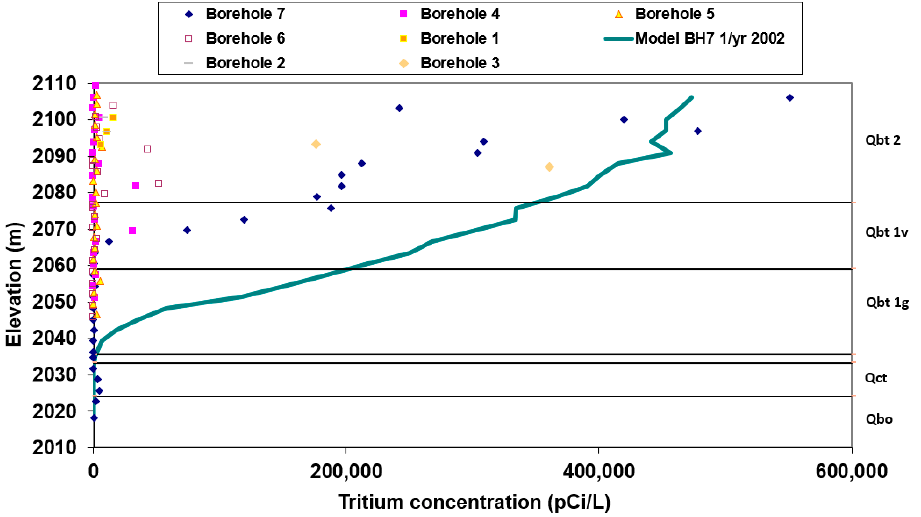
Figure 8. Simulated (at Borehole 7 location) and measured tritium concentrations for the year 2002.